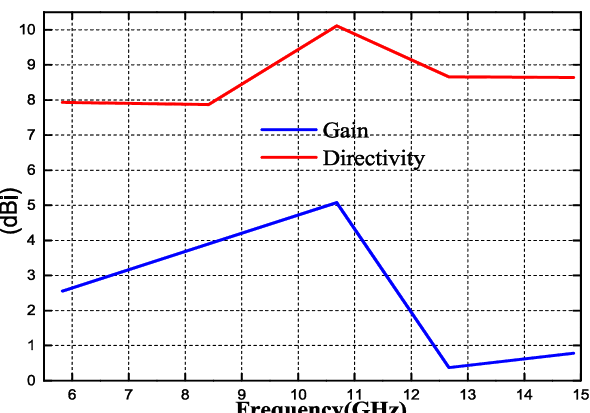
Figure 9: Extracted effective medium parameter (6 GHz)